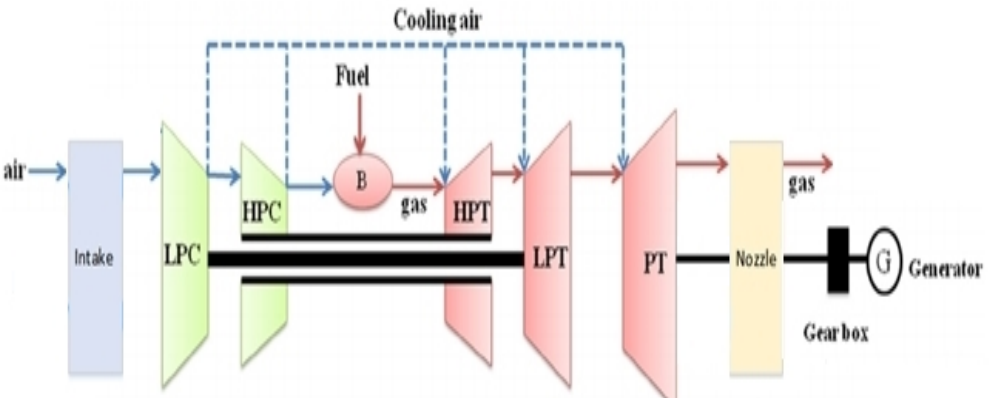
Figure 1. Three-axis gas turbine schematic Validation of Extended Model: After the development of the model, the validation process was carried out to ensure the model results and the level of modeling accuracy. This process was carried out in two different sections (validation with test data and Zuria correction